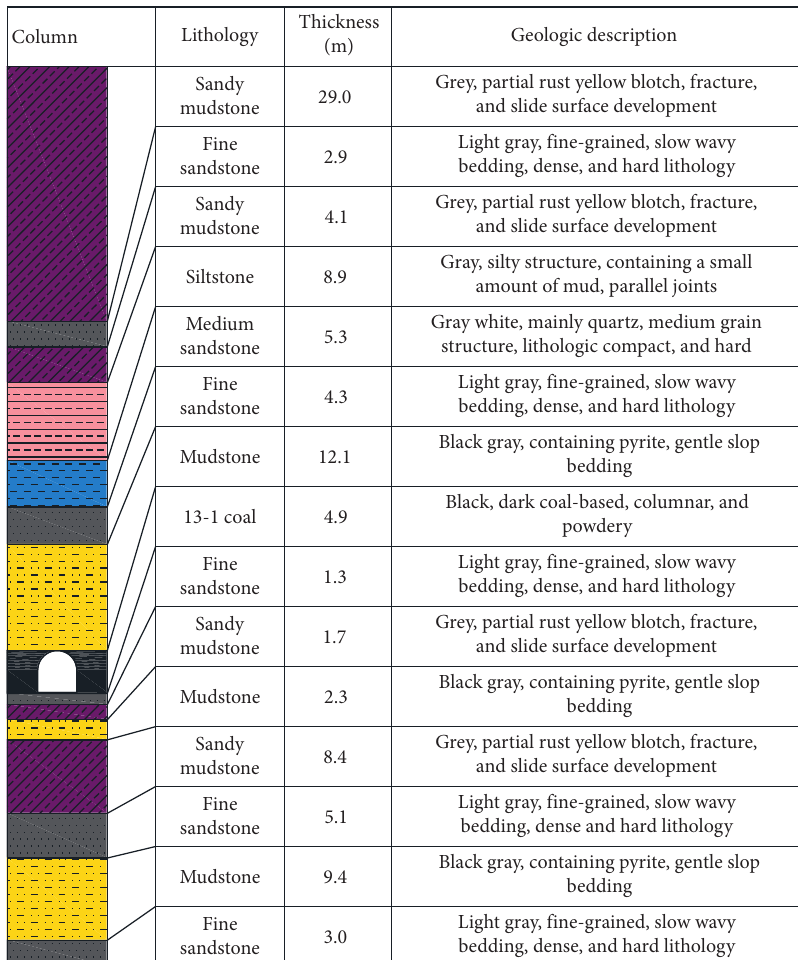
Figure 2: 121304 longwall face schematic view.